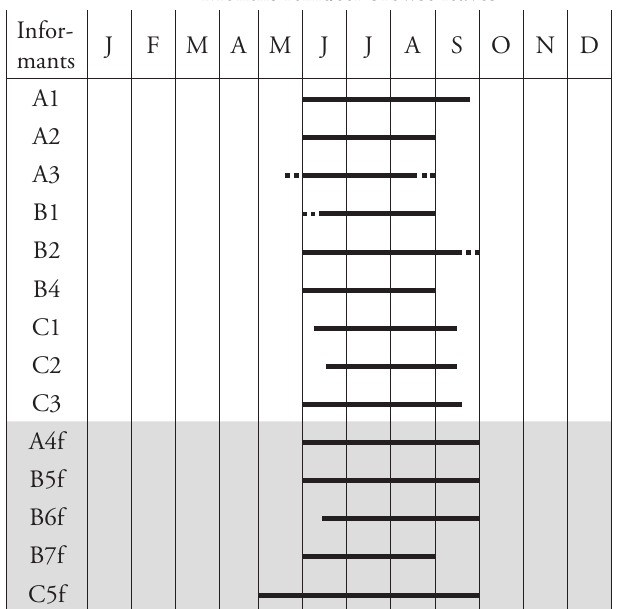
Fig. 2 . Informant responses on questions when reindeer browse leaves from Betula spp. and Salix spp. The information was drawn by the informants on graphs representing one year. Information from informants B3, B8f and C4 are not included because they declared that they could not define when reindeer use different plants and/or did not participate in the second